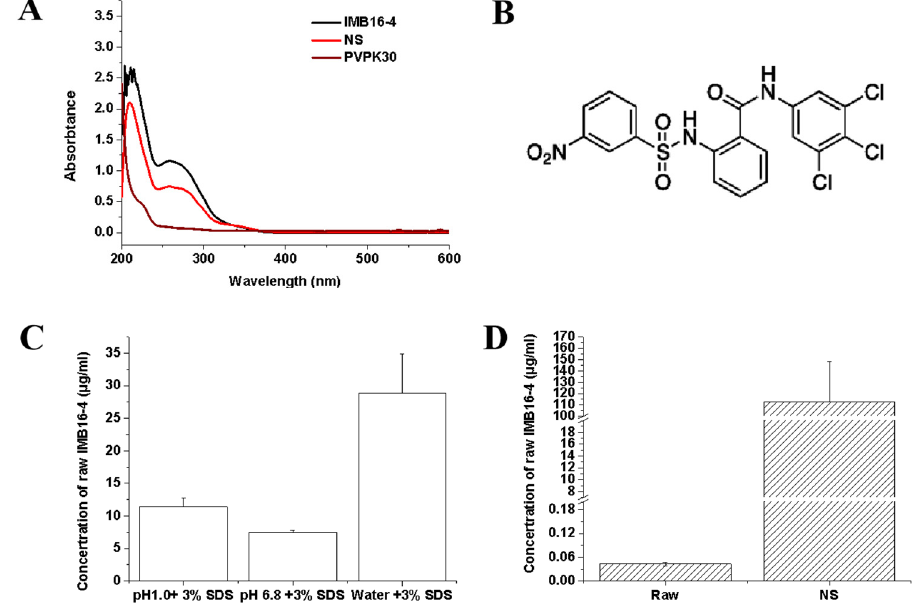
Figure 3. Characterization of pure IMB16-4 and NS: ( A ) UV–Vis absorption spectra of NS, PVPK30, and pure IMB16-4. ( B ) The chemical structural formula of IMB16-4. ( C ) Equilibrium concentrations of pure IMB16-4 and NS in different media containing 3% SDS. ( D ) The equilibrium concentrations of NS and pure IMB16-4 in water at 25 °C.